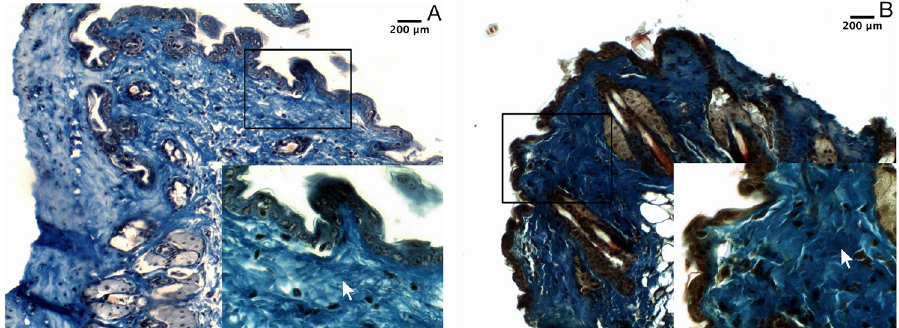
FIGURE 3 - Photomicrographs of skin stained with Masson’s trichrome to observe collagen fibers (x100, details x400). (A) Female mouse skin from group 3 treated with vehicle and (B) female mouse skin from group 2 treated with L-arginine 10%.